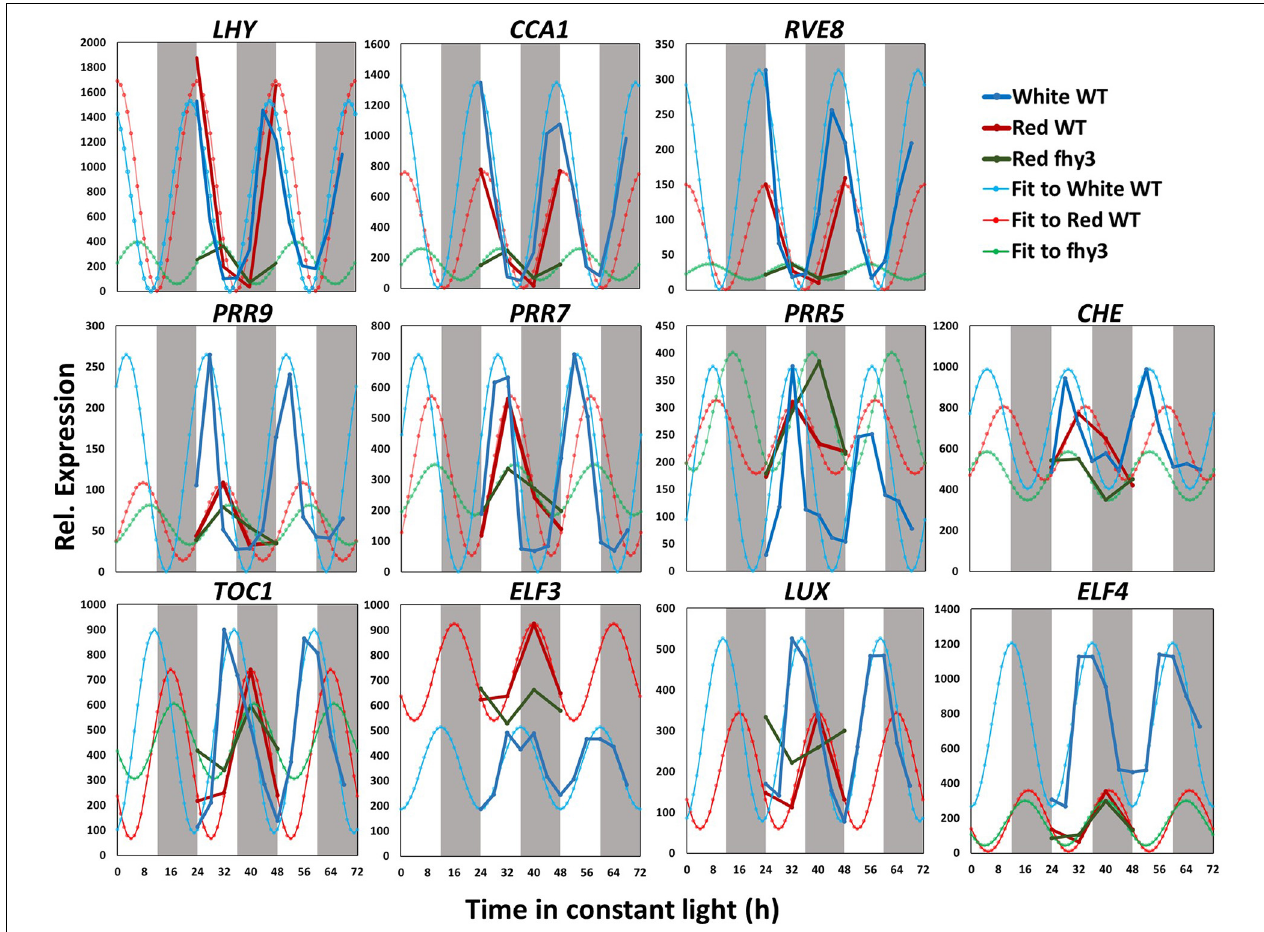
FIGURE 4 | Changes in central clock gene expression in white light, red light and in the fhy3 mutant. Mean microarray data values and mathematically fitted waveforms are shown for central clock genes in wild type (WT) seedlings in constant white and in wild type and fhy3 seedlings in constant red light. Grey bars represent subjective day and